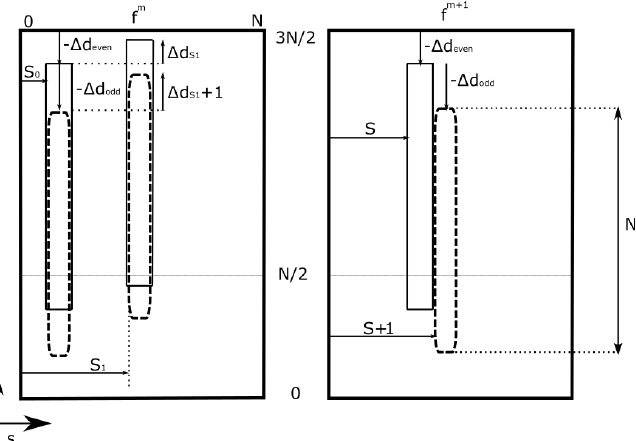
Figure 11. Data related in the computation of two consecutive columns, with indexes S and S + 1, at stage m + 1, from two columns of the previous stage, with indexes S 0 and S 1